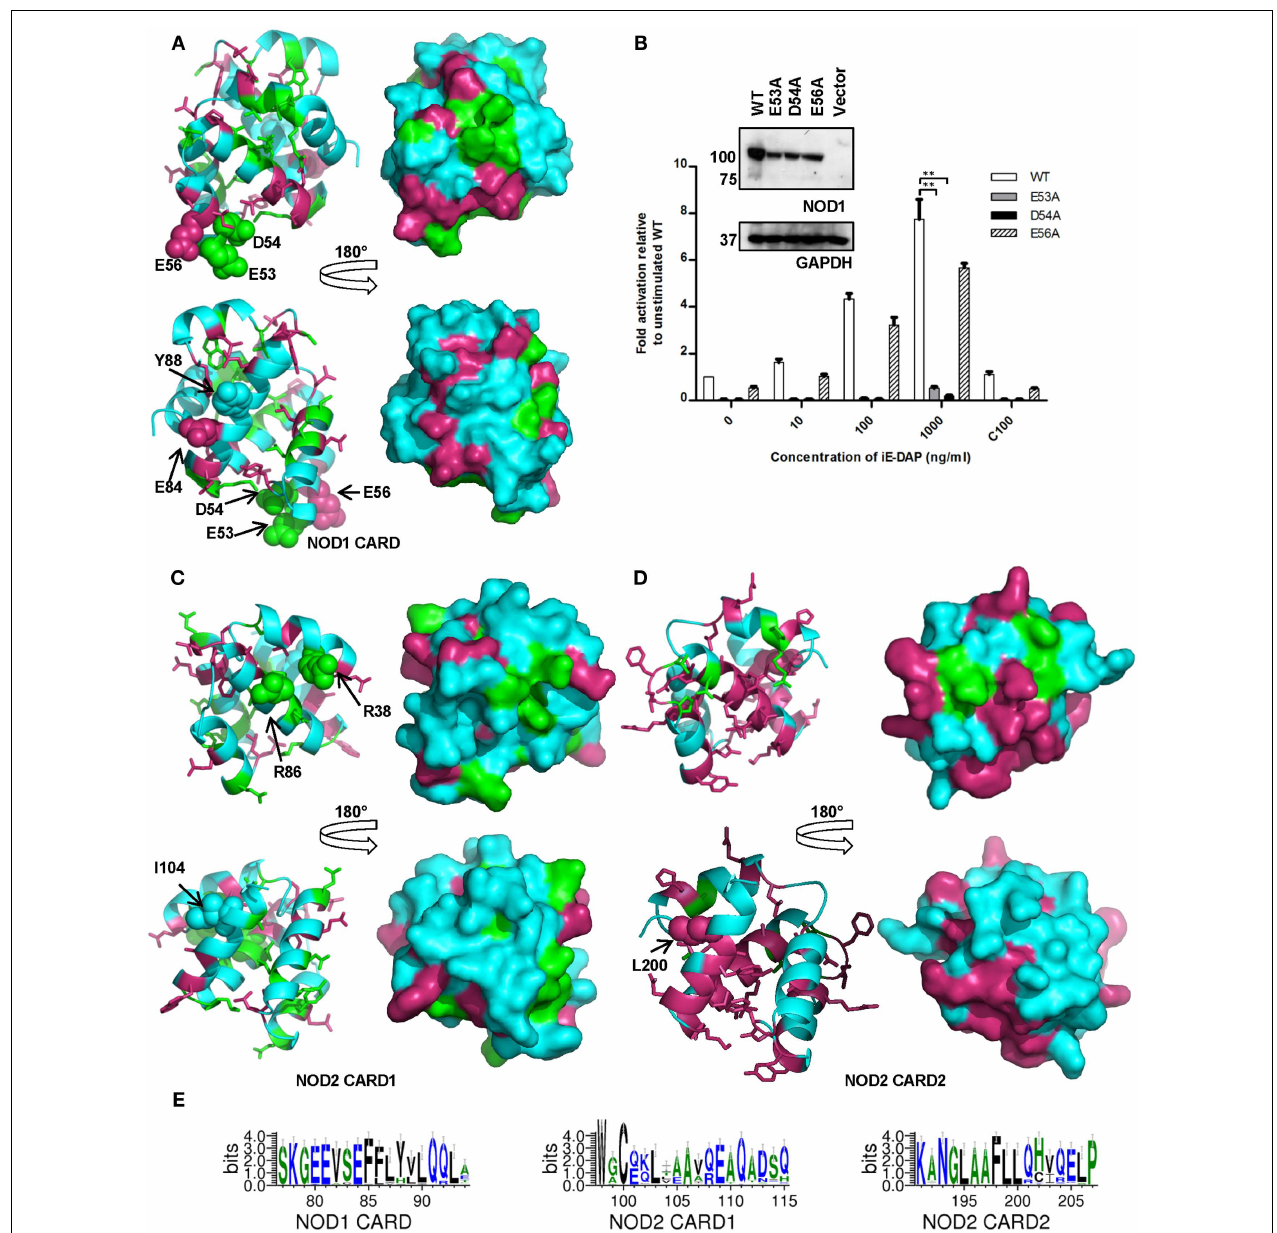
FIGURE 4 |Amino acid conservation in the NOD1 and NOD2 CARDs . Cartoon and surface representations of NOD1 CARD (A) , NOD2 CARD1 (C) , and NOD2 CARD2 (D) showing amino acids conserved across all species (green) and conserved across mammals (pink). In each panel the top and bottom images are related by a 180° rotation around the vertical axis.The left and right images are cartoon and surface representations of the same view respectively. Residues previously implicated in interaction with RIP2 (NOD1 – E53, D54, E56; NOD2 – R38, R36) or in the process of ubiquitination (NOD1 – E84,Y88; NOD2 – I104, L200) are labeled and presented as spheres. Conservation is mapped